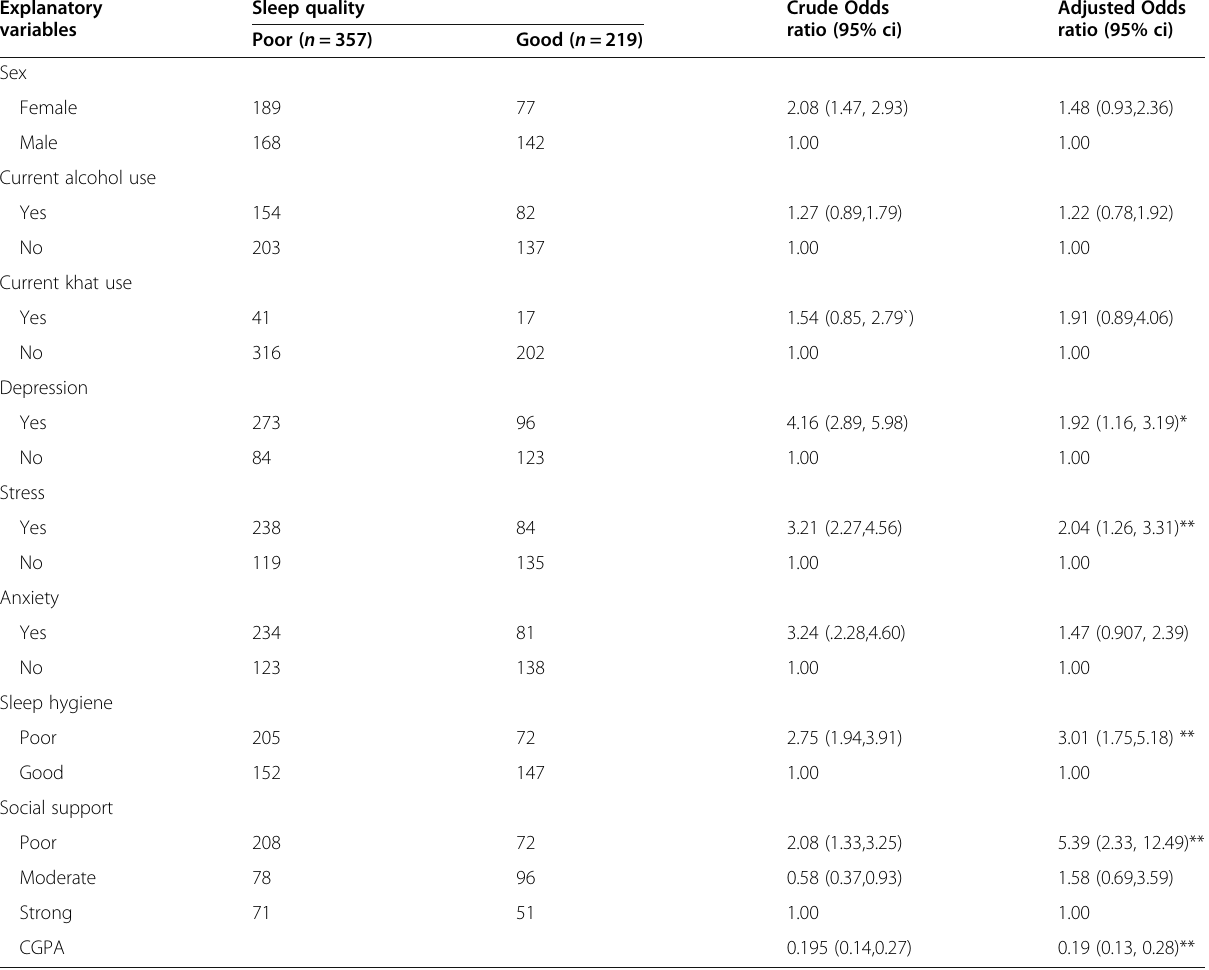
Table 4 Logistic regression showing association between factors and sleep quality among undergraduate medical students at Tikur Anbessa specialized hospital Addis Ababa Ethiopia, 2019 ( N = 576) Explanatory variables